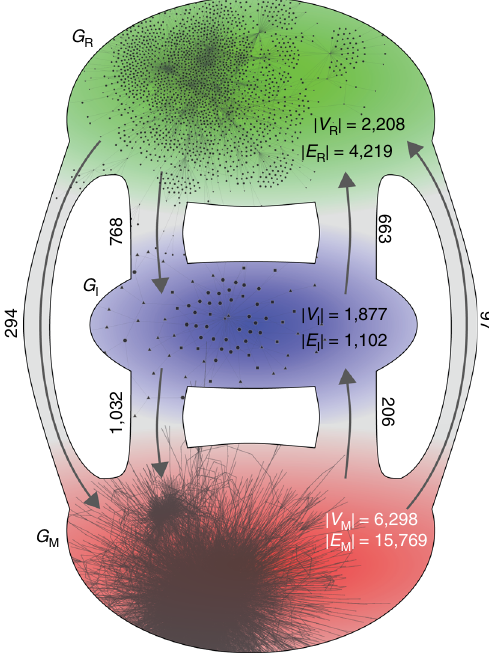
Fig. 1 Sketch of the domain organization of the integrative E. coli network. The gene regulatory domain, G R , ( top ) is predominantly connected to the metabolic domain, G M , ( bottom ) via a protein-interface layer, G I . For each domain, the number of vertices, | V | , and the number of edges, | E | , are given as well as the number of inter-domain edges (attached to the arrows ). For illustrative purposes, snapshots of the largest weakly-connected components of G R , G I and G M are included